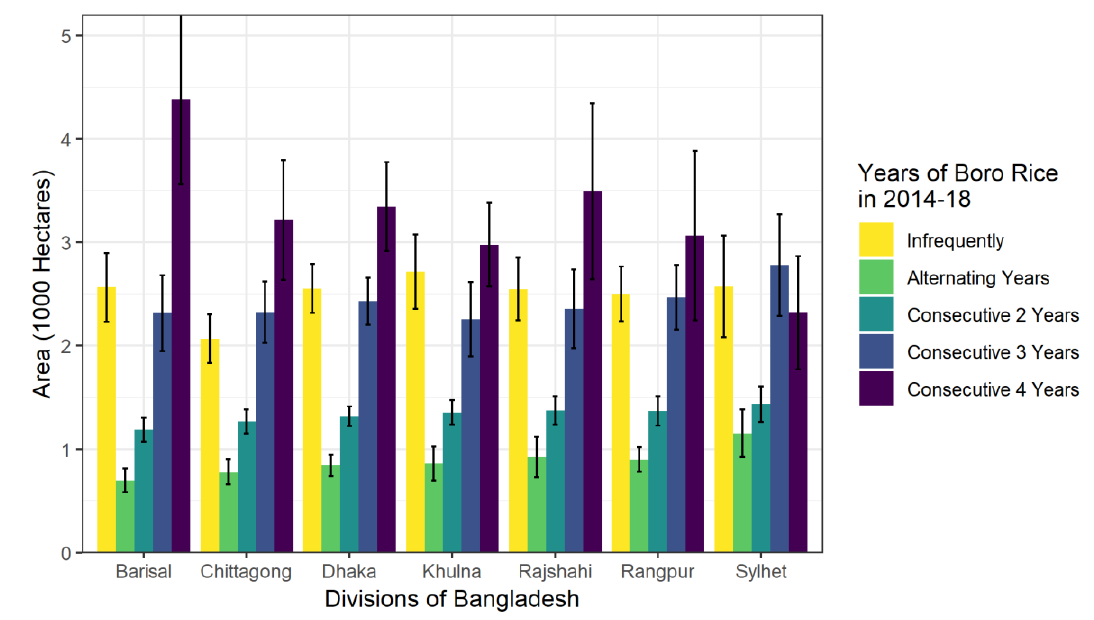
Figure 7. Temporal consistency in boro rice cropping patterns.